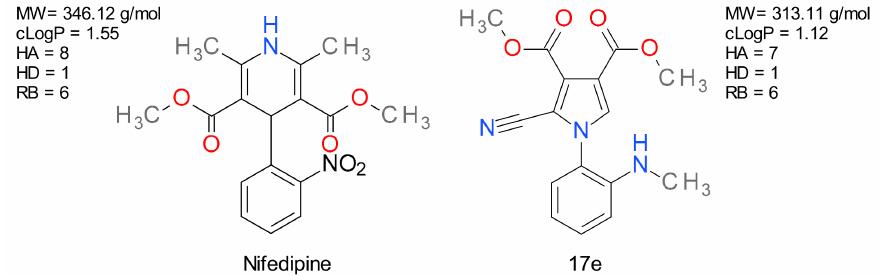
Figure 3. The structure of nifedipine and of the new pyrrole compound 17e together with relevant structural descriptors (MW = molecular weight, cLogP = logarithm of the octanol/water partition coefficient, HA = hydrogen bond acceptors count, HD = hydrogen bond donors count, RB = rotatable bonds